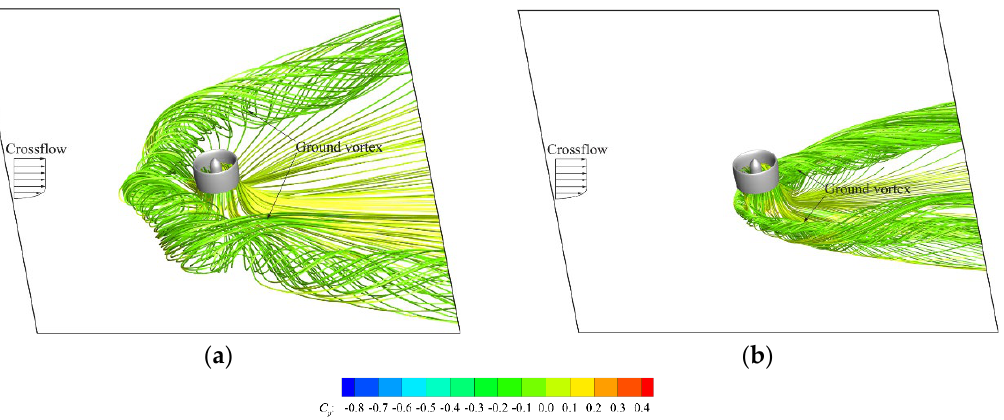
Figure 27. Ground vortex at different advance ratios at h / D = 0.5, α = 75°: ( a ) J = 0.3; ( b ) J = 0.5. Streamlines are colored by pressure coefficients.